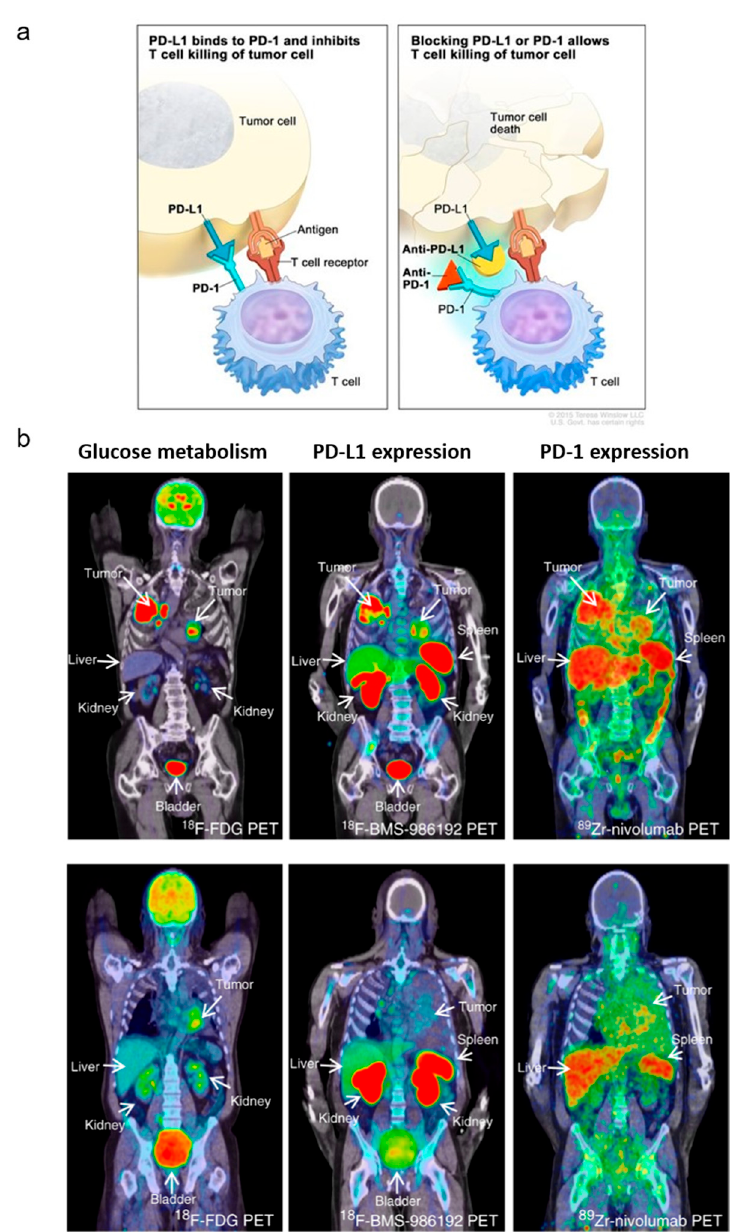
Figure 7. Programmed cell death protein (PD-1) / programmed death-ligand 1 (PD-L1) imaging. ( a ) Blocking the binding of PD-L1 to PD-1 with an immune checkpoint inhibitor (anti-PD-L1 or anti-PD-1) allows T cells to kill tumor cells. Figure courtesy of Terese Winslow for the National Cancer Institute © (2020) Terese Winslow LLC, U.S. Govt. has certain rights. ( b ) PET scans of two patients imaged with [ 18 F]FDG that measures glucose metabolism (left), [ 18 F]BMS-986192 that measures PD-L1 expression (middle), and [ 89 Zr]Zr-nivolumab (right) that measures PD-1 expression. Heterogenous tracer uptake observed between and within lesions. Figure was reproduced with permission from Nat. Commun. 2018 , 9: 4664 [100], under a Creative Commons Attribution 4.0 International License.